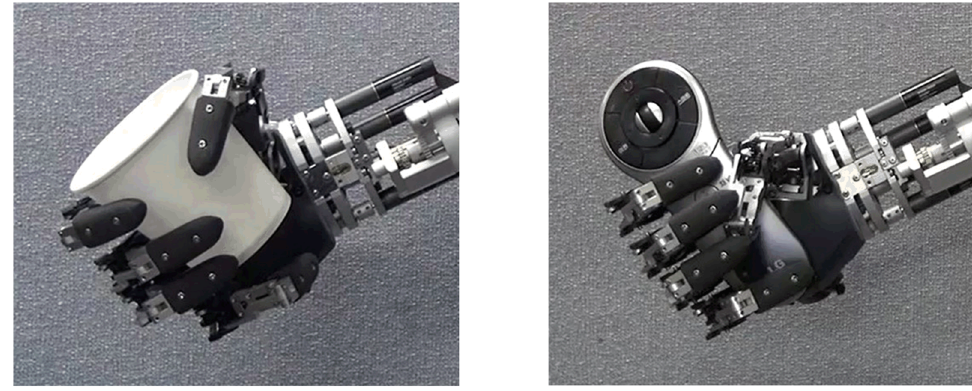
Figure 8. Self-adaptive grasping motions using diverse objects.